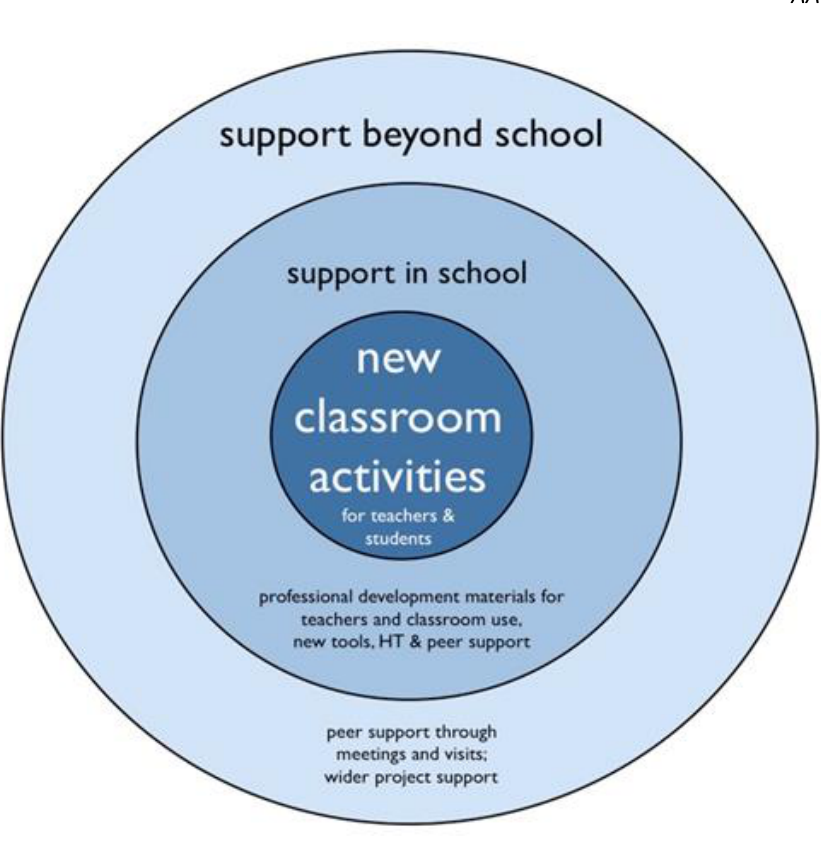
Figure 6 EIA’s SBPD model (Walsh & Power, 2011) EIA’s developmental